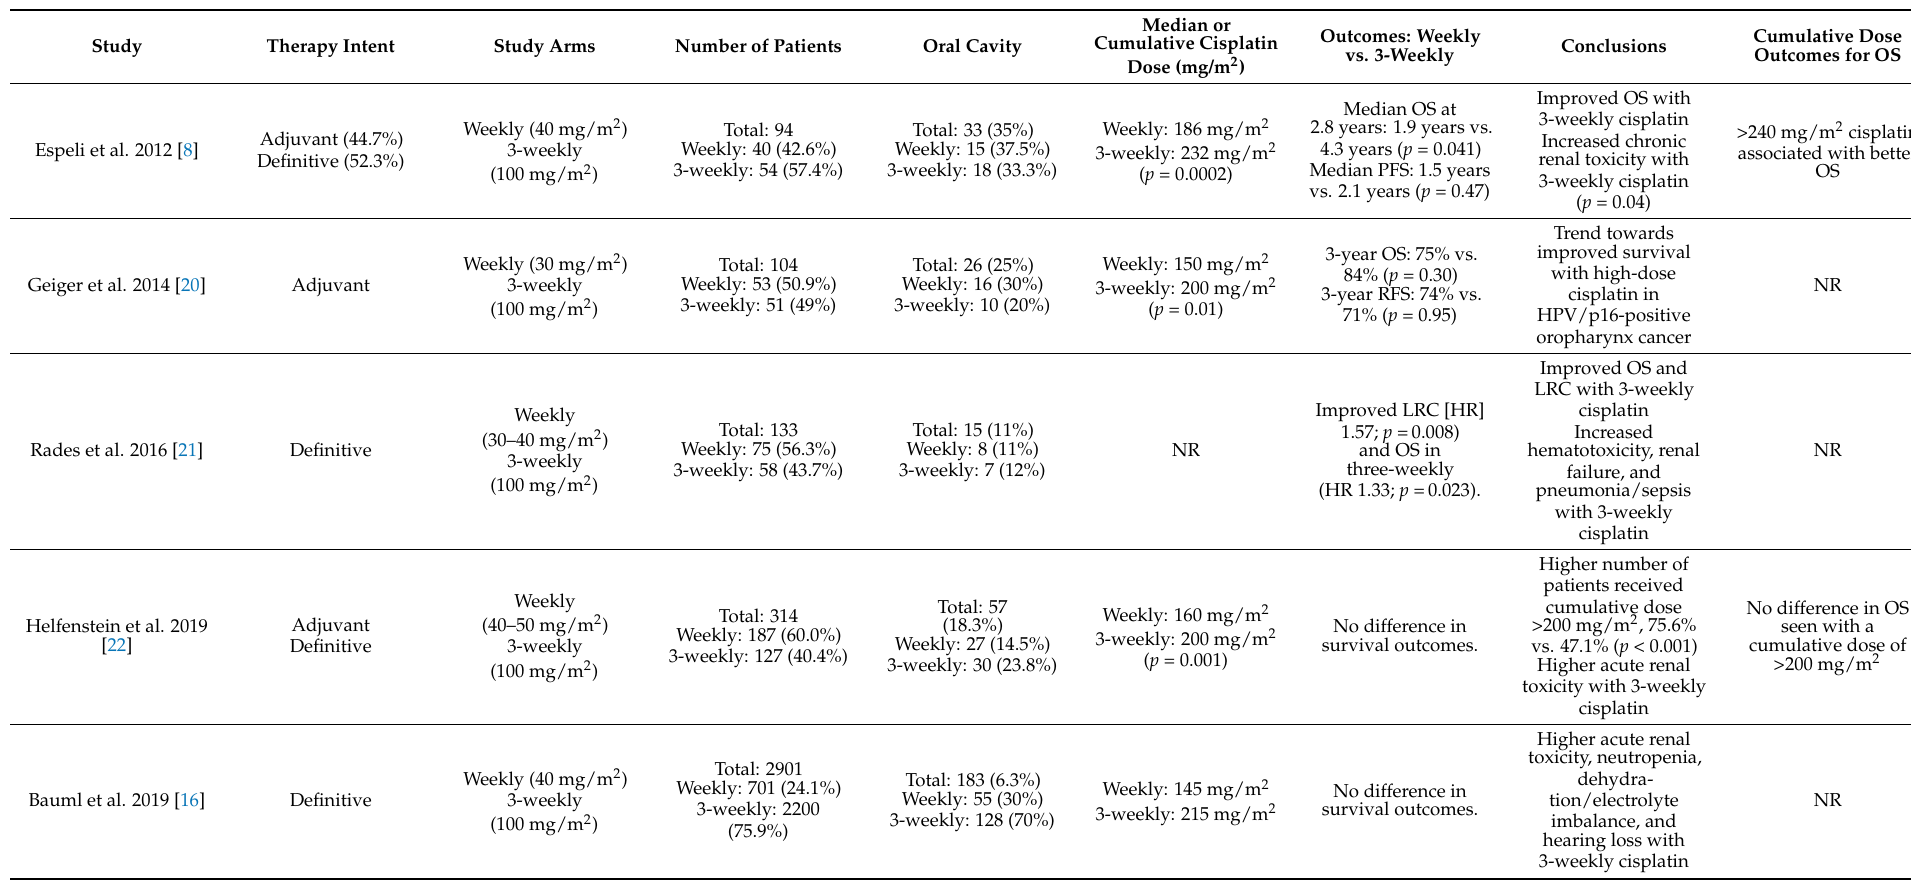
Table 3. Characteristics of retrospective and prospective studies comparing weekly versus three-weekly cisplatin. Abbreviations used are as follows: CI, confidence interval; HPV, human papillomavirus; HR, hazard ratio; LRC, locoregional control; NR, not reported; OS, overall survival; PFS, progression free survival; RFS, recurrence free